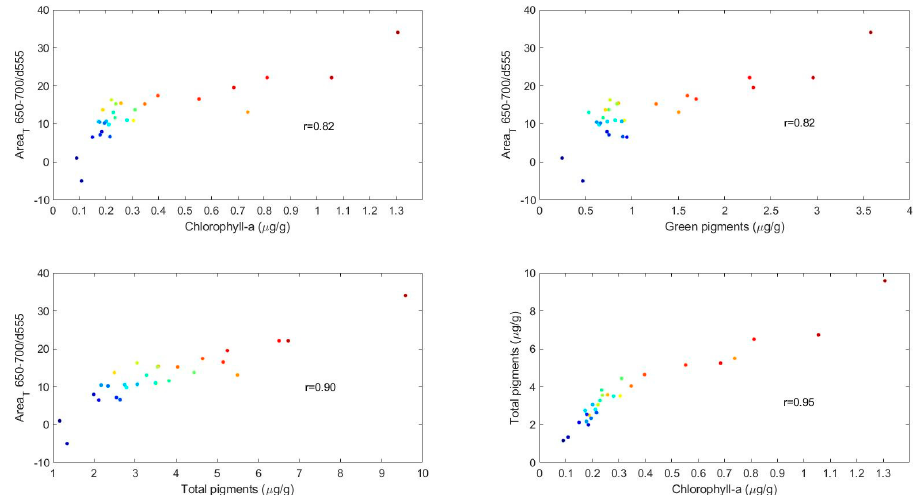
Figure 6. Correlation between HSI and chlorophyll a, green pigment and total pigment. The last correlation highlights the narrow link between total pigment and chlorophyll a variations. The red dots indicate the top of the core and the blue color is for the bottom.